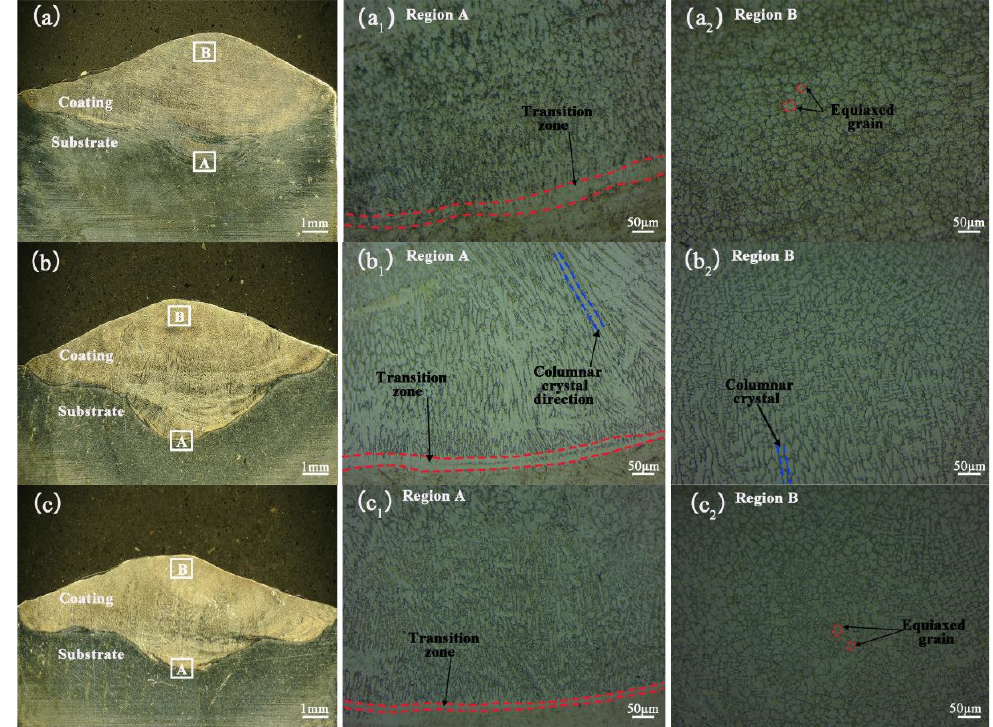
Figure 2. Optical micrographs of the coatings on the FeCrMnCuNiSi 1 powder-cored wire at different cladding currents. ( a , a 1 , a 2 ) 200 A; ( b , b 1 , b 2 ) 220 A; ( c , c 1 , c 2 ) 240 A.